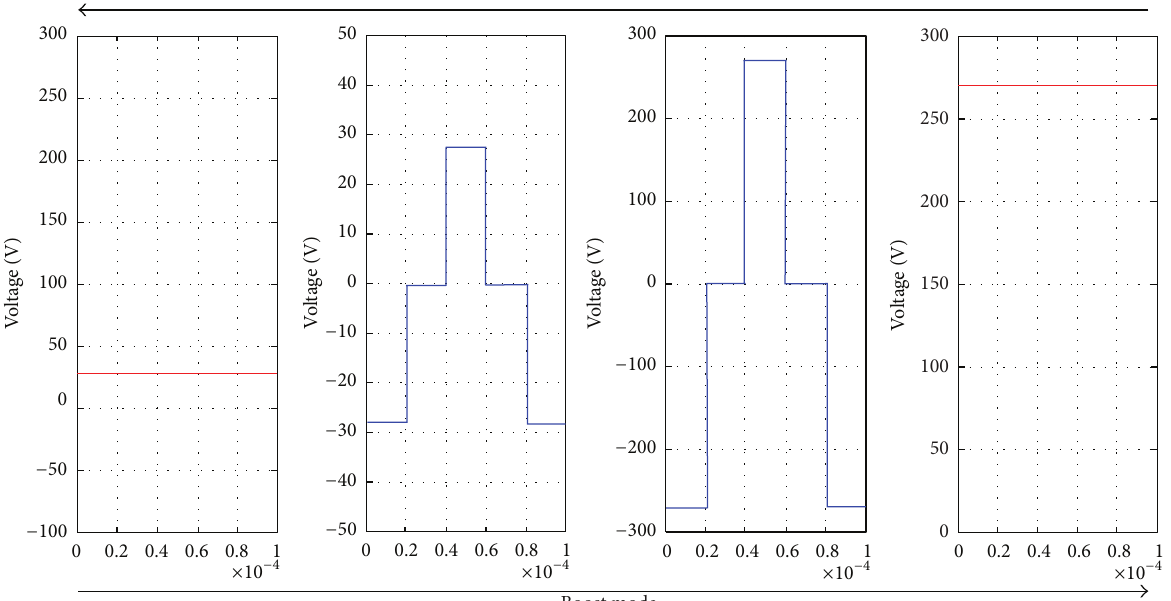
Figure 4: Voltage transformations in buck and boost mode.